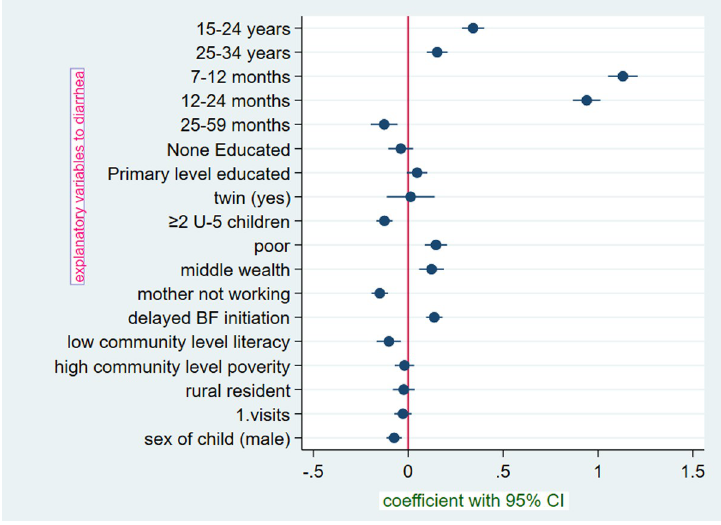
Fig 2. Coefficient plot of both community and individual-level factors of diarrhea among under five years children in East Africa with respective 95%